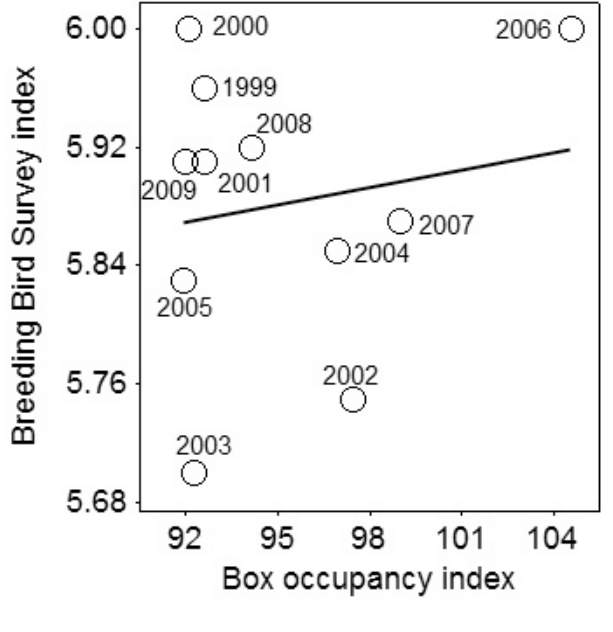
Fig. 2 . Survey-wide annual Breeding Bird Survey indices (Sauer et al. 2011) of Tree Swallow populations and corresponding box occupancy indices (combined for all sites) between 1999 and 2009 (Fig. 1). Individual year data points are